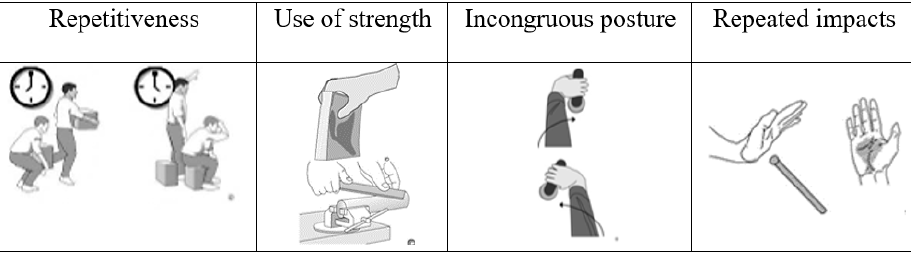
Figure 17. Some of the main situations which should be taken into account for a correct risk